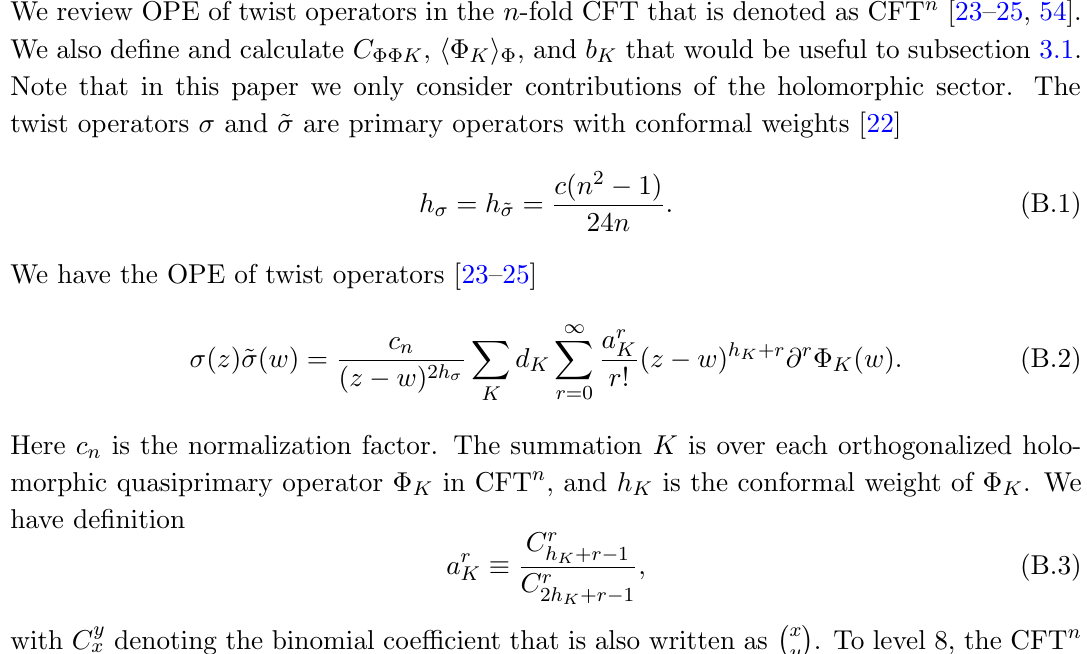
for all these quasiprimary K